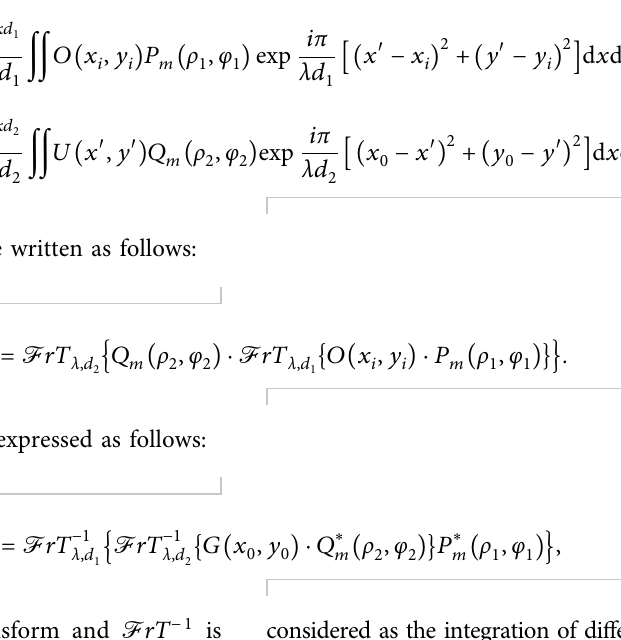
, y ) is the DRPE information obtained after the two phase masks; d 0 0 ( x , y ) is an object at plane 1; O i i 1